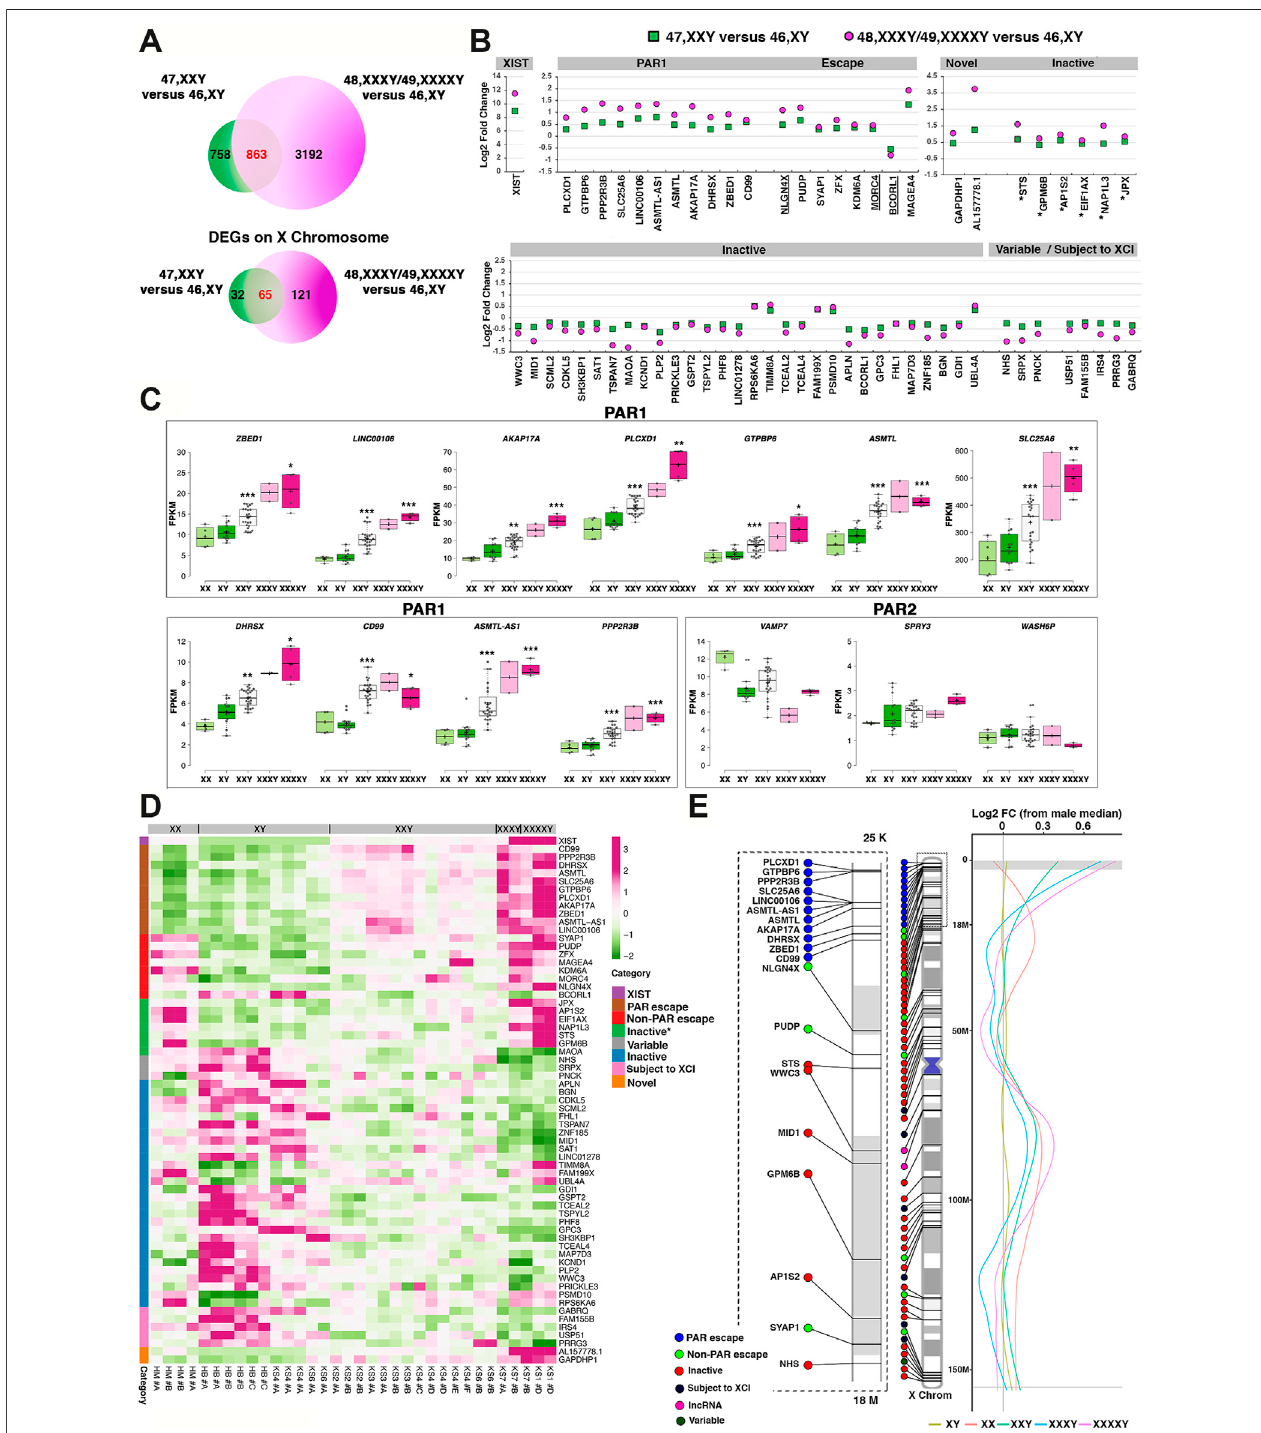
FIGURE 3 | Transcriptomic pro fi ling of KS- and HGA-iPSCs identi fi es proportional and inversely proportional X chromosome dosage-dependency of X-linked genes. (A) DEGsnumber anddistributionacrossthecomparisons 47,KSversus46,XYand48/49,XXXY/XXXXY versus46,XYintheglobaltranscriptome(upperVenn) or in the X chromosome (lower Venn). (B) Log 2 fold change of shared dosage-sensitive X-linked DEGs. Six groups of DEGs are shown: genes from the PAR1 region, biallelic genes escaping Xi (Escape), monoallelic genes expressed from the active X (Inactive), and genes whose Xa/Xi status has never been described (Novel). Inactive DEGs labeled with asterisks have been previously described as escape genes. Variable and subject to XCI categories were assigned accordingly to previous studies. Underlined DEGs were previously described as inactive or variable (Tukiainen et al., 2017). (C) Boxplots showing the X dosage-dependent FPKM expression of